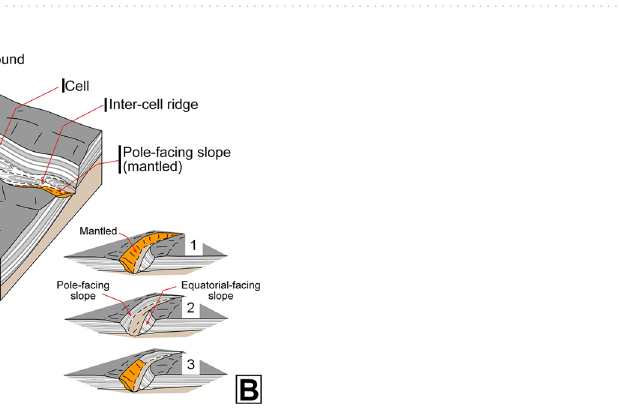
Figure 3. ( A ) Sketch showing a perspective view of the NPLD stratigraphy, which characterizes widespread sections of the NPLD troughs. Key morphologic features include the presence of elongate enclosed depressions (cells), inter-cell ridges, and interior mounds. The mounds and the cell walls exhibit concentrically layered exposures, indicating that the troughs’ volumes are largely due to in-situ excavation (see Fig. 2 and S4 for examples of relevant optical and topographic observations). Also indicated is the location of a pole-facing slope section where young mantles cover the truncated layered outcrops (see Figs. 4, S8, S9 for examples of relevant optical observations). ( B ) View of typical trough exposures based on the complete presence or absence of pole-facing layers (1 and 2) and troughs showing partial mantle obscuration of the underlying truncated strata